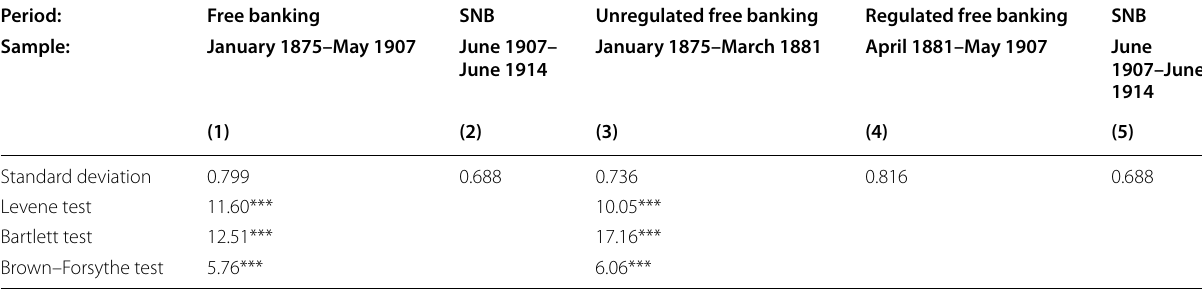
Different ANOVA tests